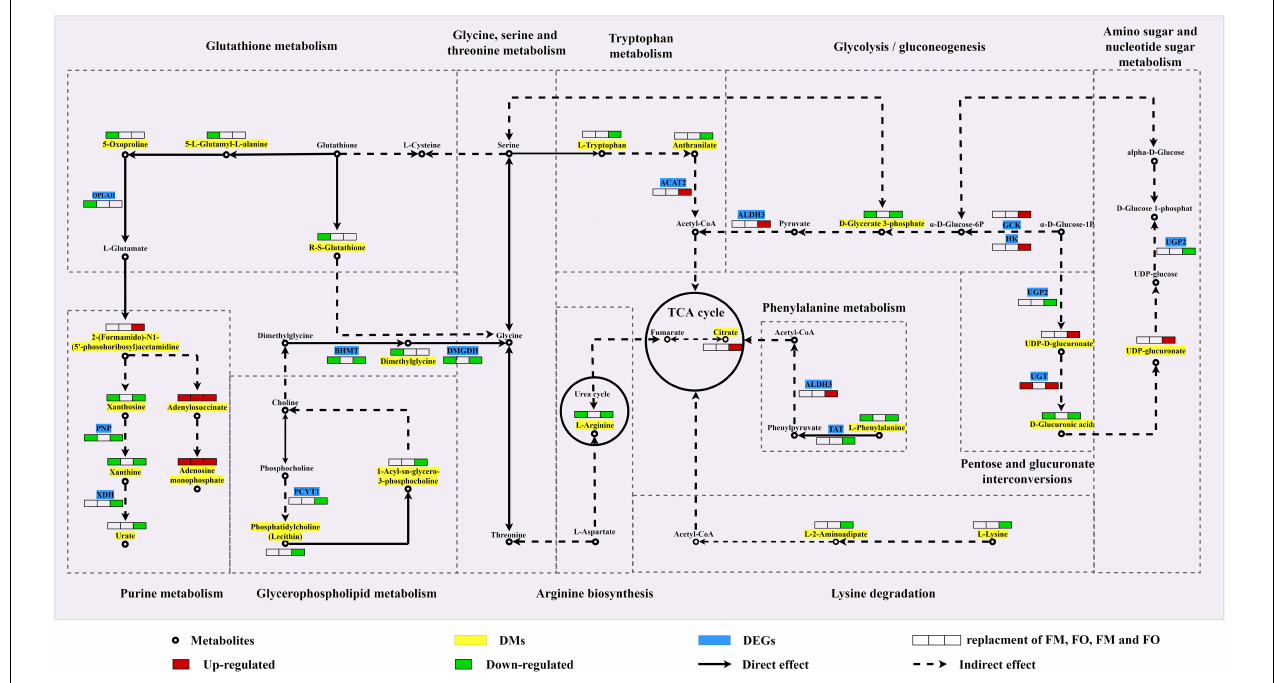
FIGURE 5 | A hypothetical integrated metabolic network of key differential metabolites and genes in significant pathways identified by multi-omics analysis between FM and FO replacement and combined replacement FM and FO based on the KEGG pathway database. Map00230: purine metabolism; map00310: lysine degradation; map00220: arginine biosynthesis; map00010: glycolysis/gluconeogenesis; map00360: phenylalanine metabolism; map00520: amino sugar and nucleotide sugar metabolism; map00260: glycine, serine, and threonine metabolism; map00040: pentose and glucuronate interconversions; map00480: